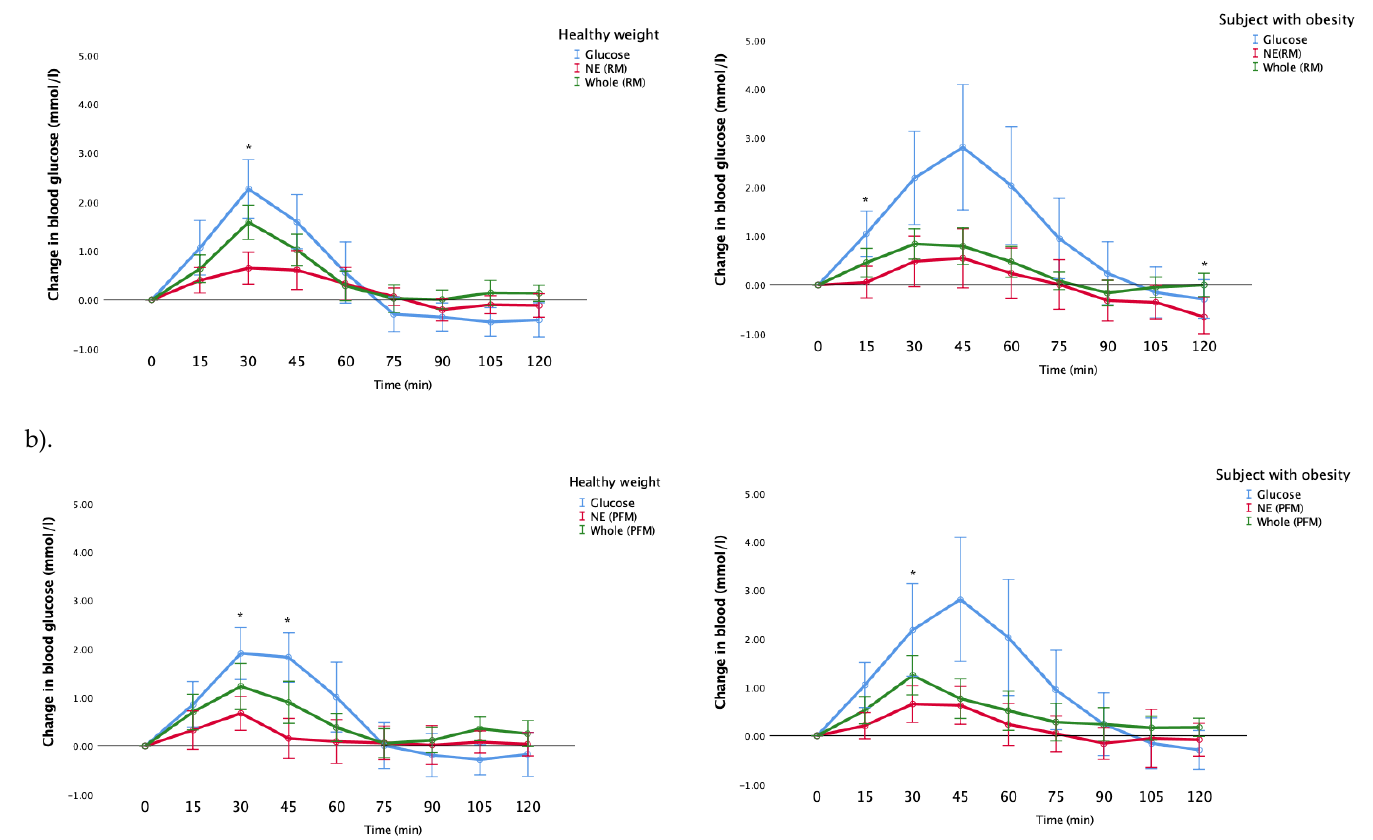
Figure 5. Comparison of the incremental changes in blood glucose values from baseline between individuals with healthy weight and obesity for each test meal. ( a ) raspberry-mango arm; ( b ) passionfruit -mango arm. * indicates the di ff erence between the nutrient-extracted fruits and whole fruit p <